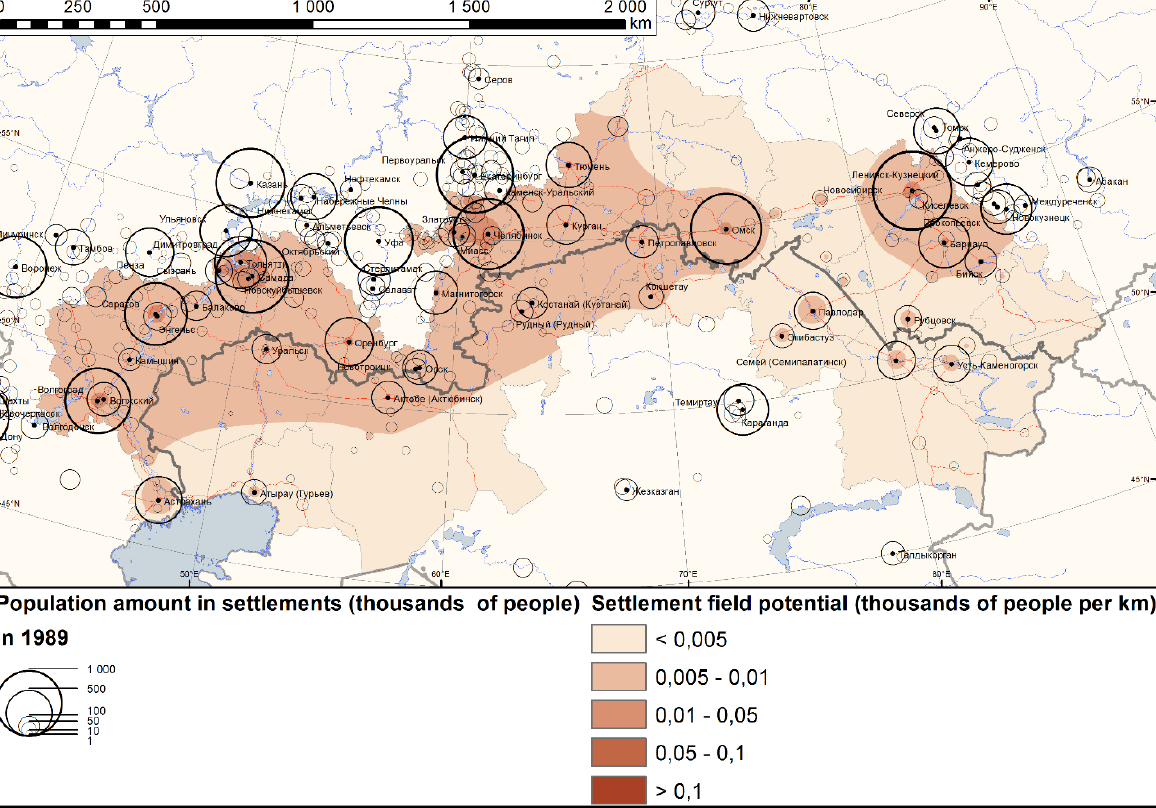
Figure 3 . Draft map visualization of the direct-distance-based settlement field potential for the Russia-Kazakhstan transborder region. WGS-84/Alberts conic projection. The map was produced basing on pixel-by-pixel computations; no spatial interpolation techniques were